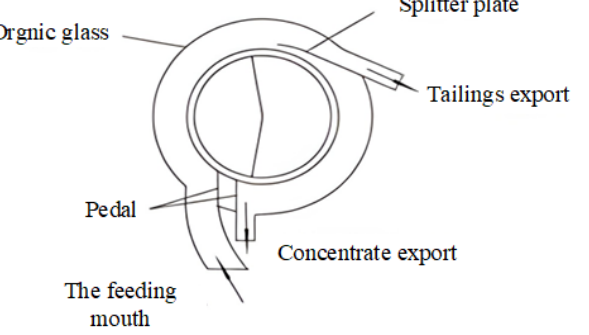
Figure 10. Air suspension dry magnetic separator [45].